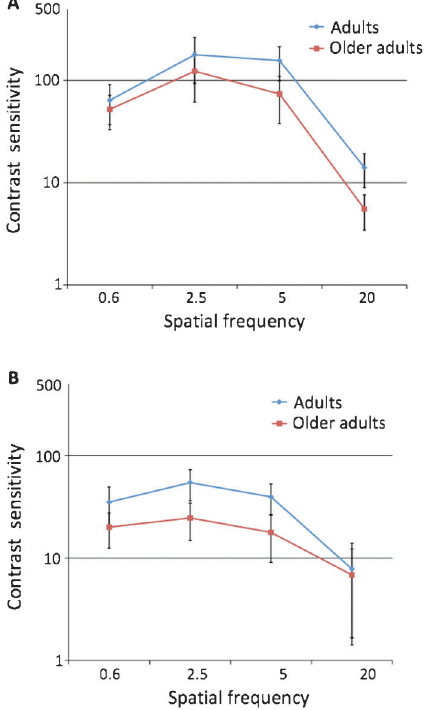
Figure 2. A , Contrast sensitivity curves of adults and older adults for linear gratings. B , Contrast sensitivity curves of the two age groups for circular concentric gratings. Data are reported as means±SD for each